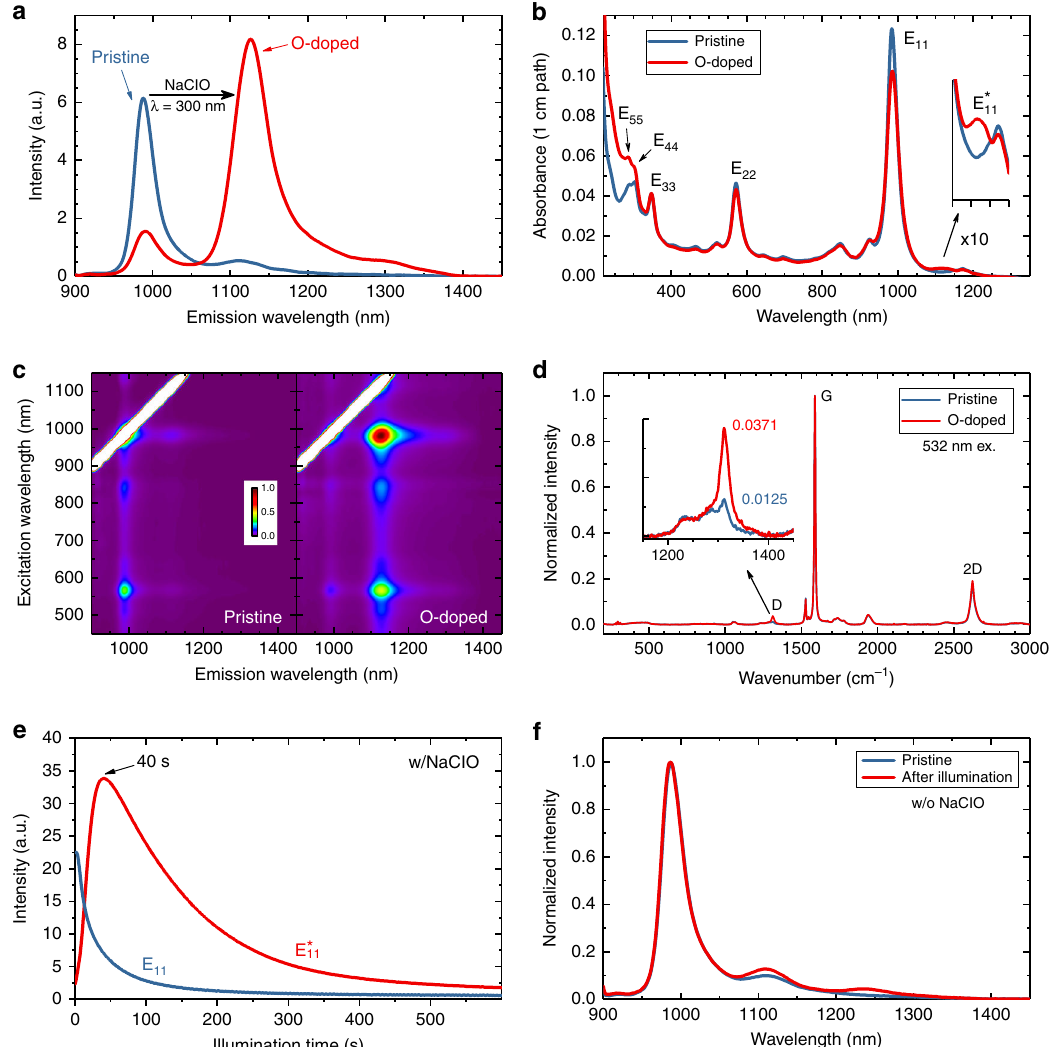
Fig. 1 Optical properties of pristine and O-doped (6,5)-enriched SWCNT samples. a Fluorescence spectra. b Absorption spectra; expanded inset shows E (cid:1) absorption feature. c Excitation-emission maps. d Raman spectra; expanded inset shows the D bands. e Emission intensities versus illumination time. f Normalized emission spectra of SWCNT samples with and without 300 nm irradiation in the absence of